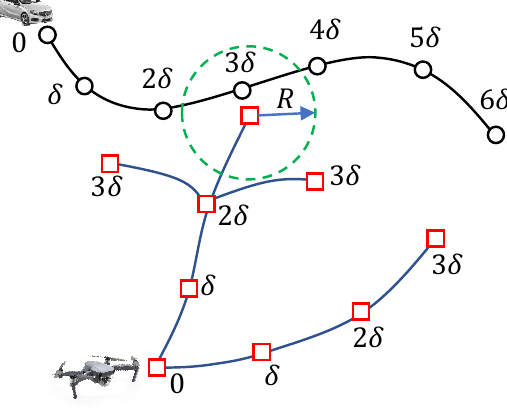
Figure 5. Illustration of the rapidly-exploring random tree (RRT)-based path